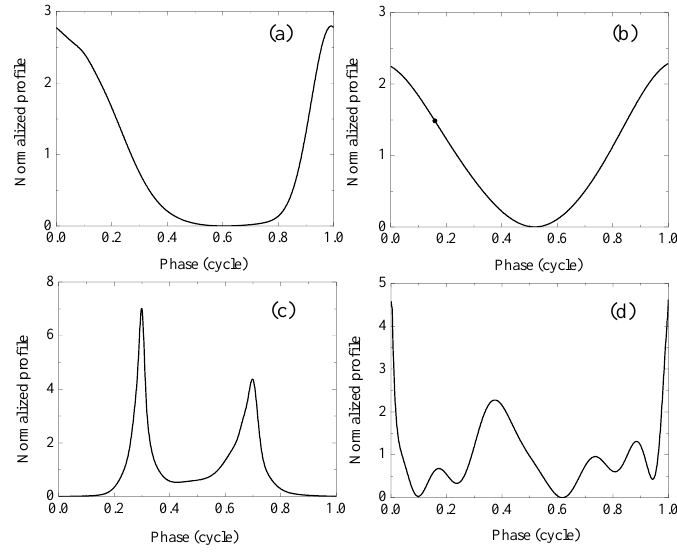
Figure 2. Normalized profiles of pulsar B1509-58 ( a ), B0540-69 ( b ), B0531 + 21 ( c ) and B0833-45 ( d ).